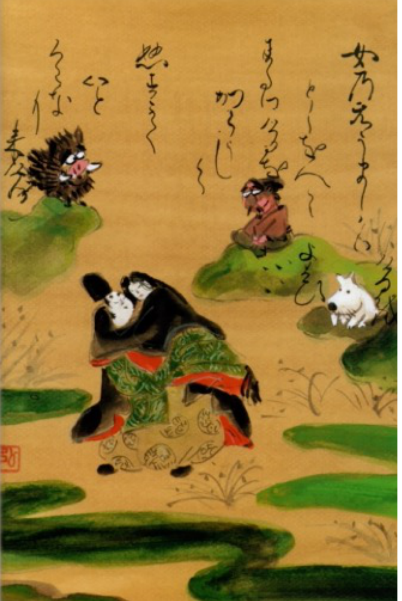
Figure 7. Kurogane Hiroshi. Ise monogatari (Tokyo: Shōgakukan, 2013), frontis. Courtesy of